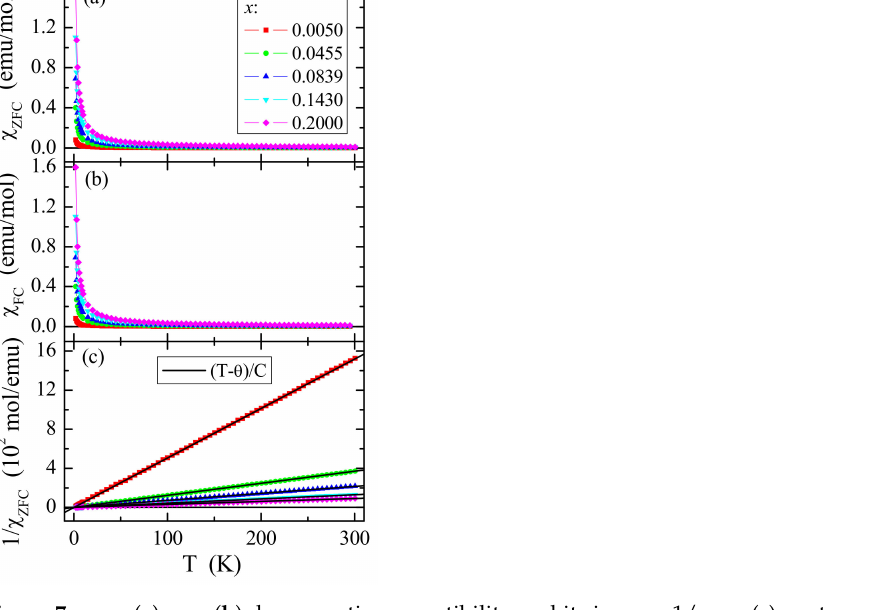
Figure 7. χ ZFC ( a ), χ FC ( b ) dc magnetic susceptibility and its inverse 1/ χ ZFC ( c ) vs. temperature T of CCGMWO solid solution for x = 0.0050, 0.0455, 0.0839, 0.1430, 0.2000, and y = 0.02 recorded at H = 1 kOe. The solid (black) line in ( b ), (T- θ )/C, indicates a Curie–Weiss behavior. Table 2. Magnetic parameters of CCGMWO solid solution.